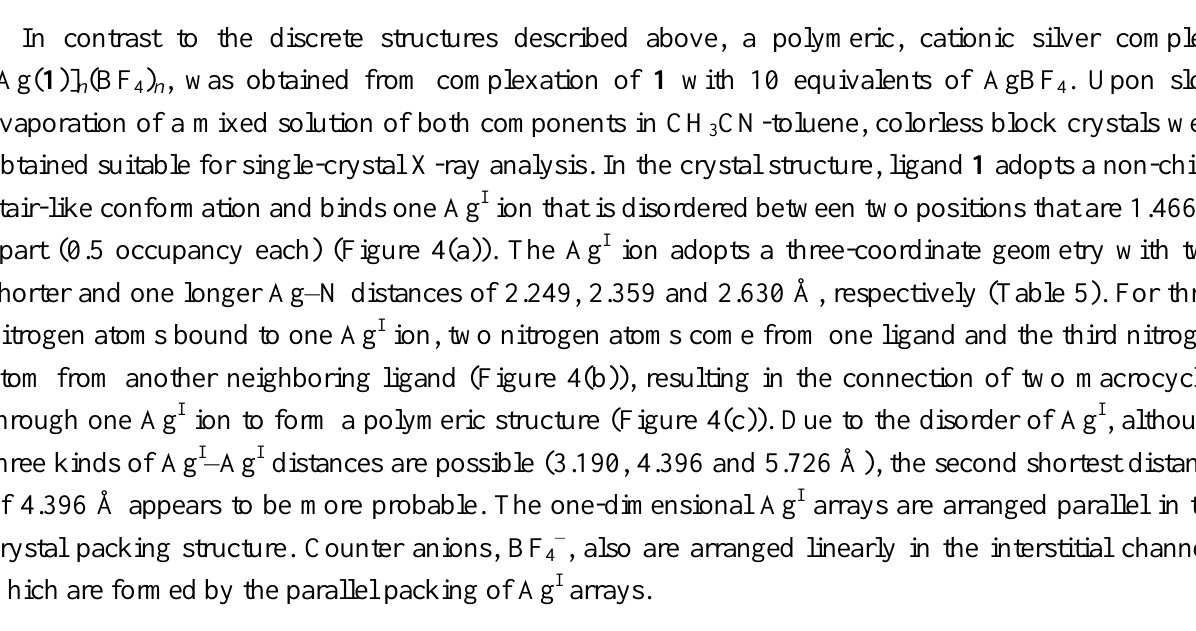
Table 4. Selected bond lengths (Å) and angles (deg) for [Ag